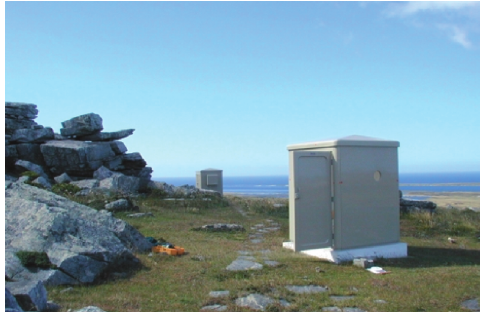
Fig. 1. The huts housing the magnetometers at Port